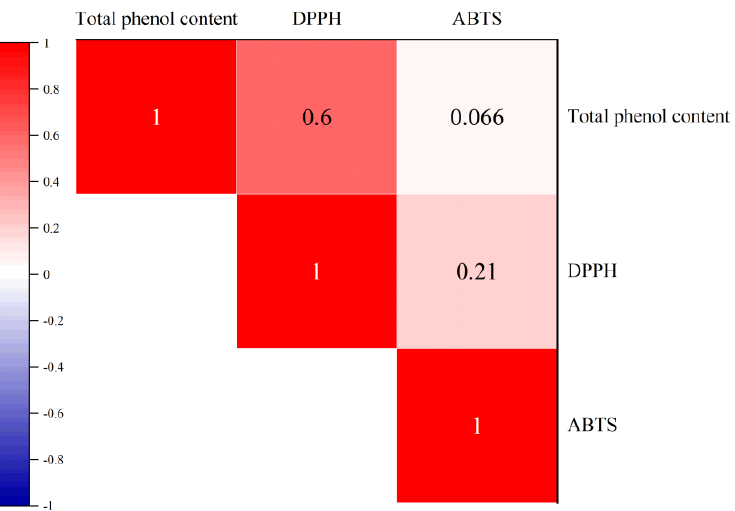
Figure 5. Correlation coefficients ( r ) among total phenol content, DPPH scavenging ability, and ABTS scavenging ability.